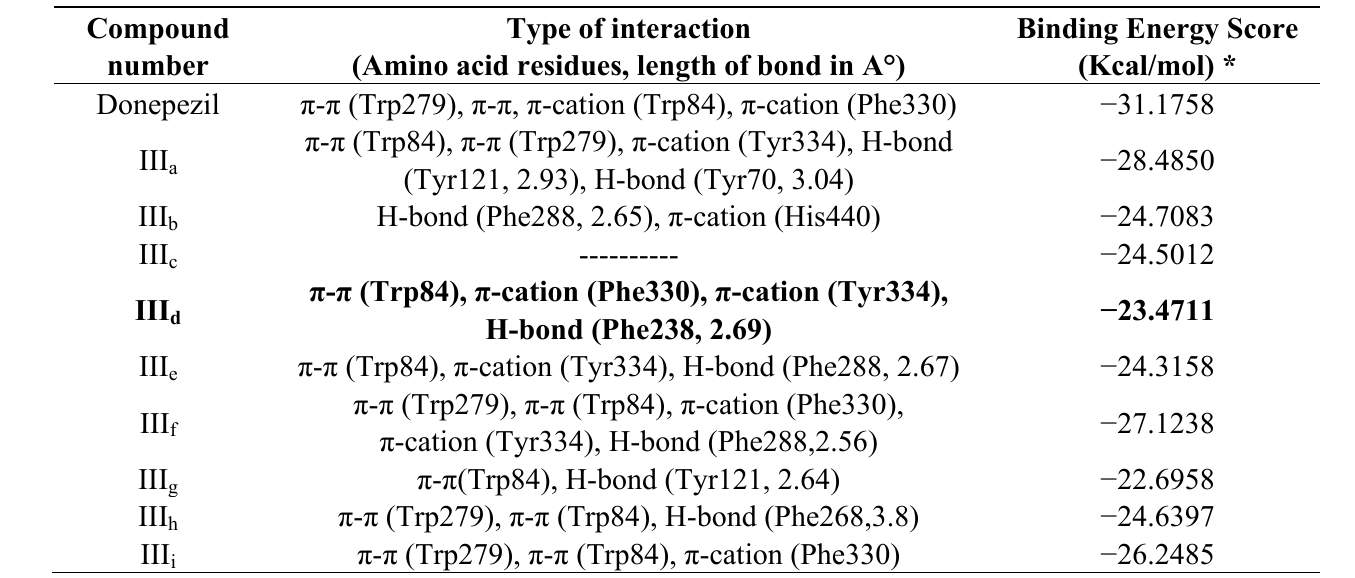
Table 2. MOE Scores of Donepezil, compounds III acid residues and their lengths